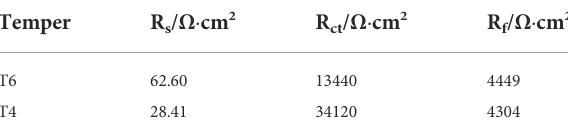
TABLE 3 Equivalent electrical circuit parameter fi tting value of three heat-treated state 2060 Al-Li alloy samples in 3.5 wt% NaCl solution.